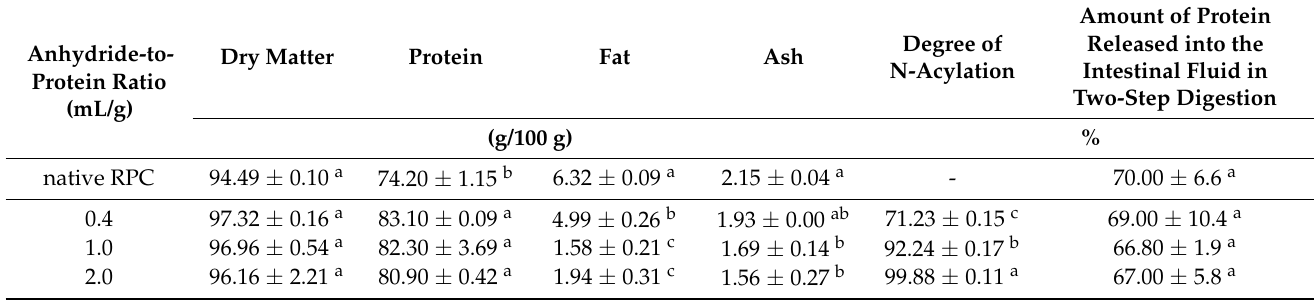
Table 1. Characteristics of native and acetylated